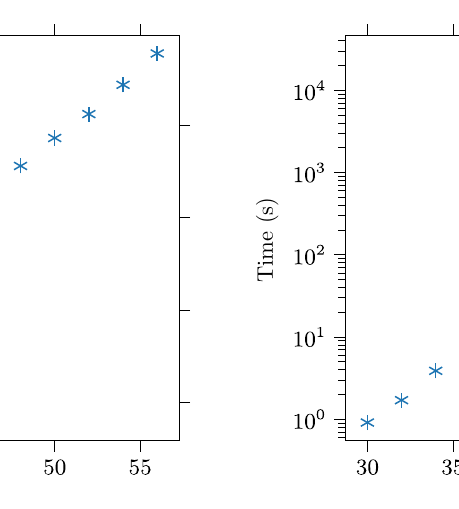
FIG. 3. The relative error in the calculation of the all-ones matrix 1 n for different matrix sizes n . The exact value of the loop hafnian for a given size n is given by the n th telephone number T ( n ) [34]; the relative error is given by | lhaf numeric ( 1 n ) − T ( n ) | / T ( n ) .